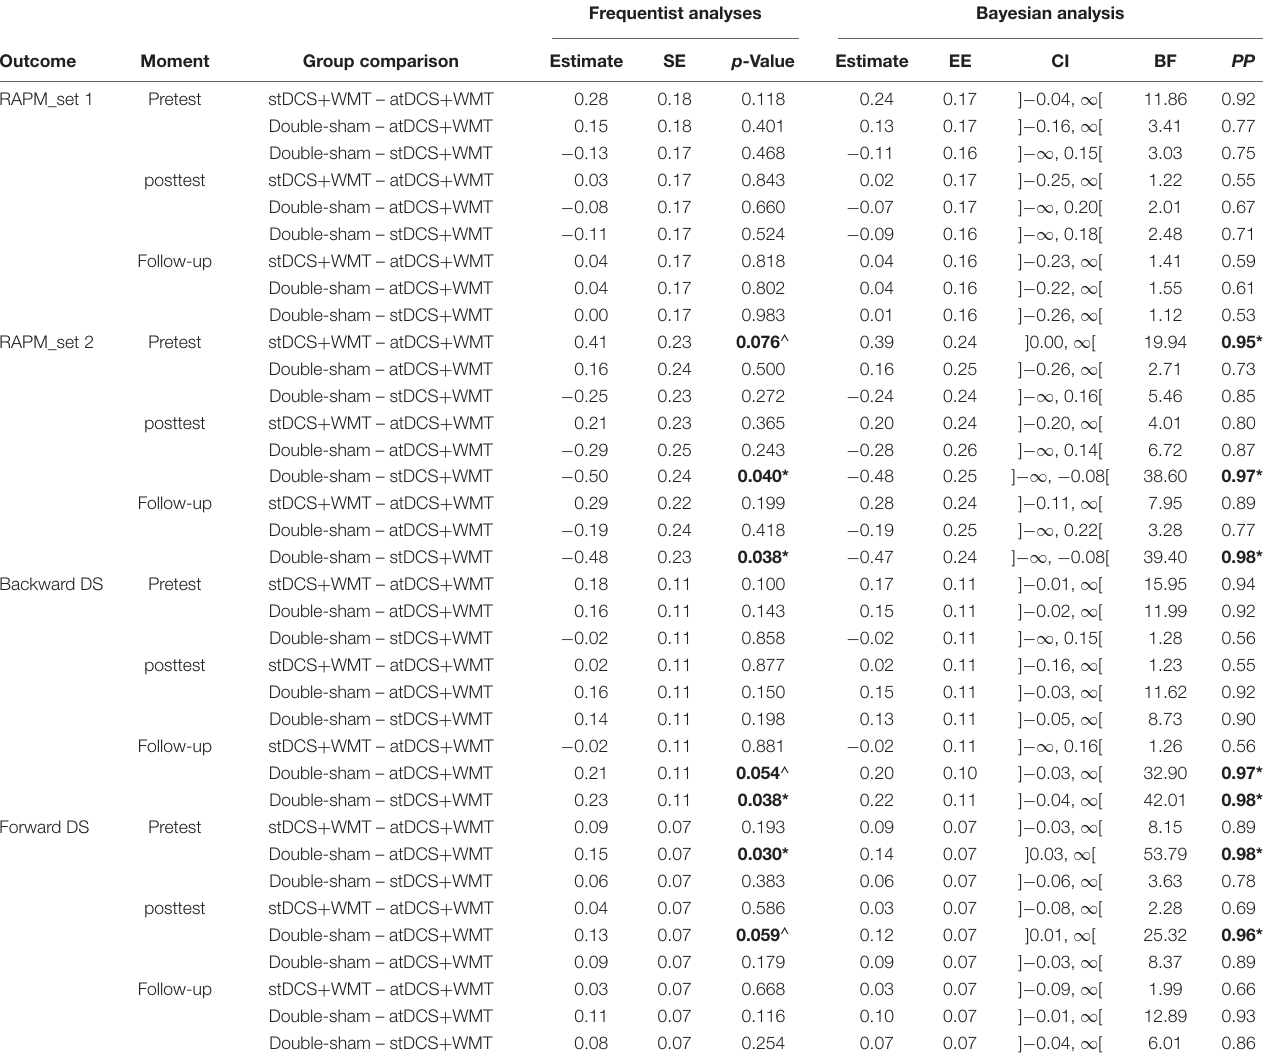
TABLE 2 | Generalized mixed-effects models results for between-group analysis per moment. Frequentist analyses Bayesian